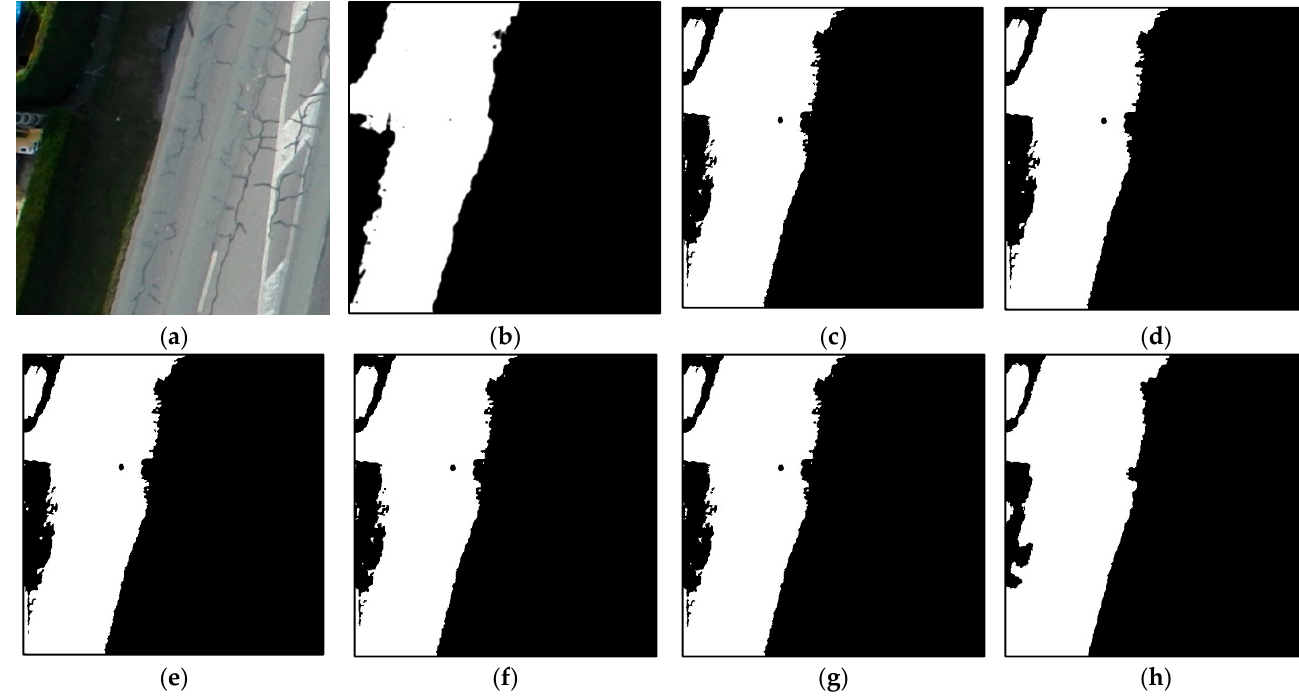
Figure 9. Visual comparison of refinement methods on Test Image 2: ( a ) input image, ( b ) ground truth, ( c ) without refinement, ( d ) opening using rectangle kernel shape ( e ), opening using cross kernel shape, ( f ) closing using rectangle kernel shape, ( g ) closing using cross kernel shape, and ( h ) dense CRF. Dense CRF performs considerably well, as most of the white noise is removed.